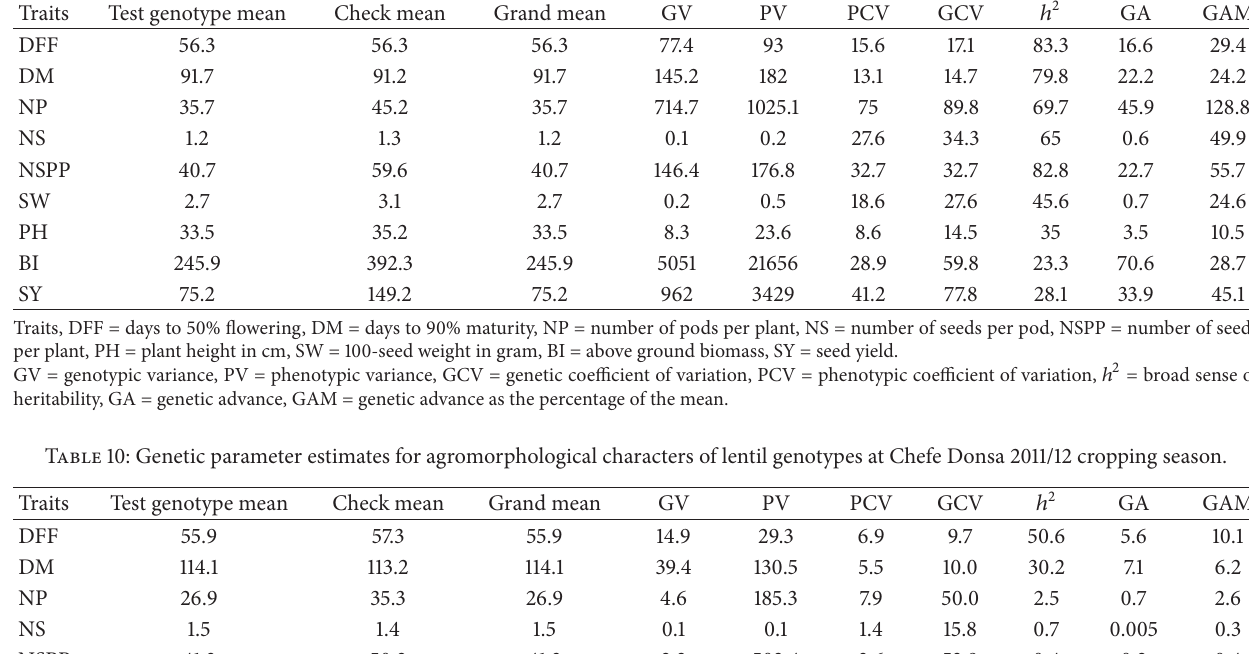
Table 9: Genetic parameter estimates for agromorphological characters of lentil genotypes at Sirinka 2011/12 cropping season. Traits Test genotype mean